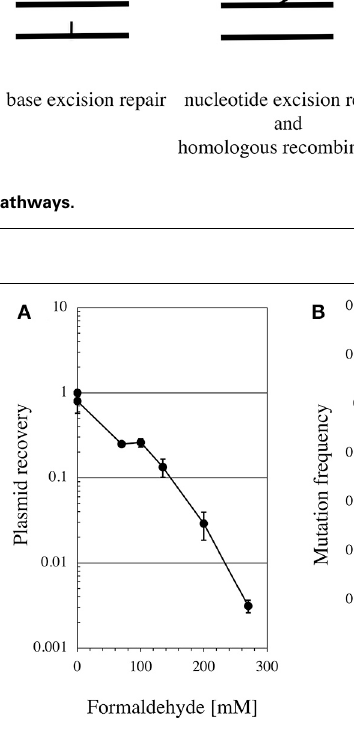
FIGURE 3 | Recovery ratio and mutation frequency of formaldehyde-treated pMY189 plasmid after replication in human cells. Method : Formaldehyde-treated pMY189 in PBS solution (0.2mL) was introduced into human SV40-transformed fibroblast cells WI38-VA13 by electroporation. The plasmid was also treated with methanol (0.3%) as a control because commercial formaldehyde solution contains methanol. After the cells were incubated for 48h, the plasmids were extracted from the cells and digested with the restriction endonuclease Dpn I to eliminate the non-replicated plasmids that retain the bacterial methylation pattern. The plasmids were introduced into the indicator bacteria KS40/pKY241 (Akasaka et al., 1992) and plated on LB agar containing nalidixic acid, ampicillin and chloramphenicol to select the plasmids containing the mutated supF gene. A portion of the cells were plated on LB agar containing ampicillin and chloramphenicol to measure the total number of transformants. Colonies were counted and plasmid recovery ratio (A) and mutation frequencies (B) were